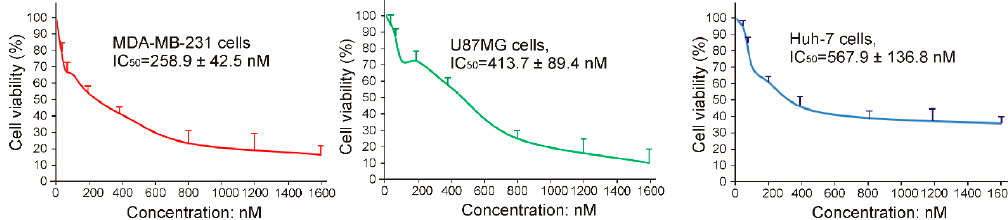
Figure 6. Evaluation of cytotoxicity and IC50 of CL-4RNV616 using EGFR positive Huh-7, MDA-MB-231, and U87MG cells.